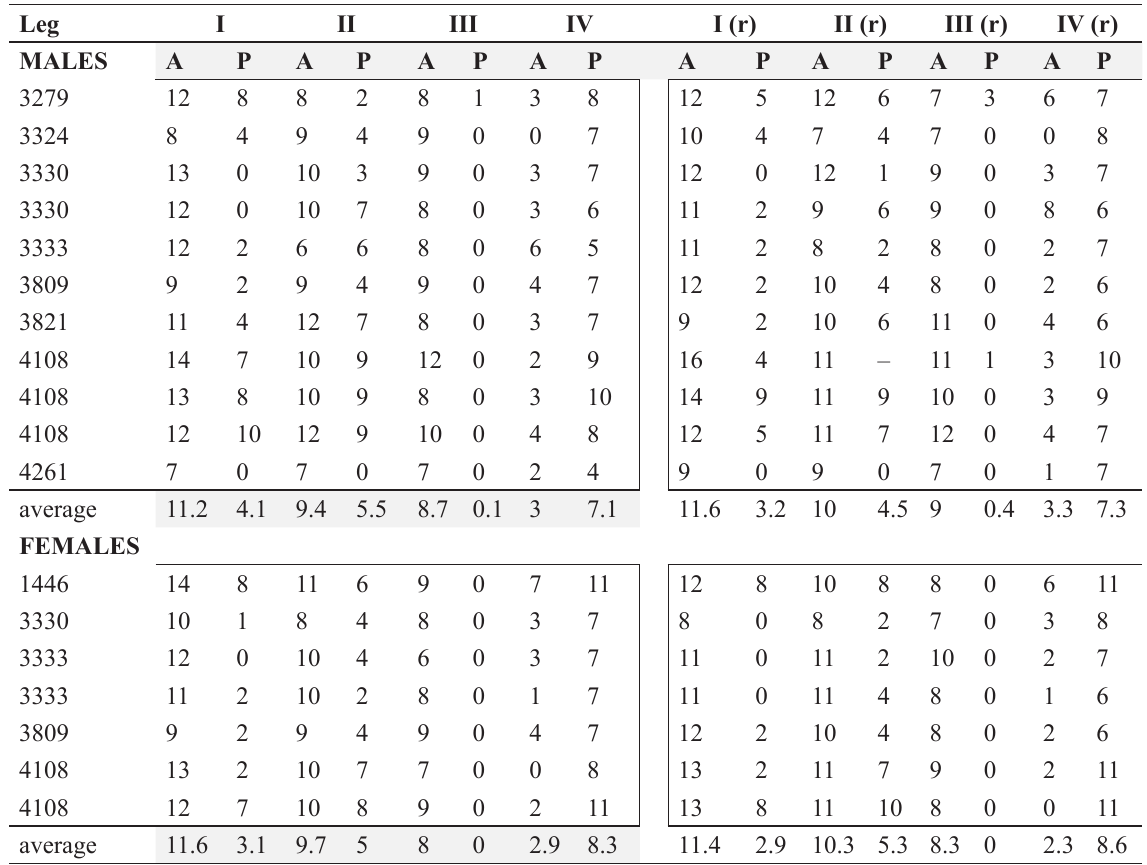
Table 2. Leiolima iberica gen. et sp. nov., number of tubercles on lateral margins of leg coxae (n = 11 males, 7 females). Averages on the right are from right coxae, and averages on the left come from the combined results on both sides. Catalogue numbers refer to the ZUPV